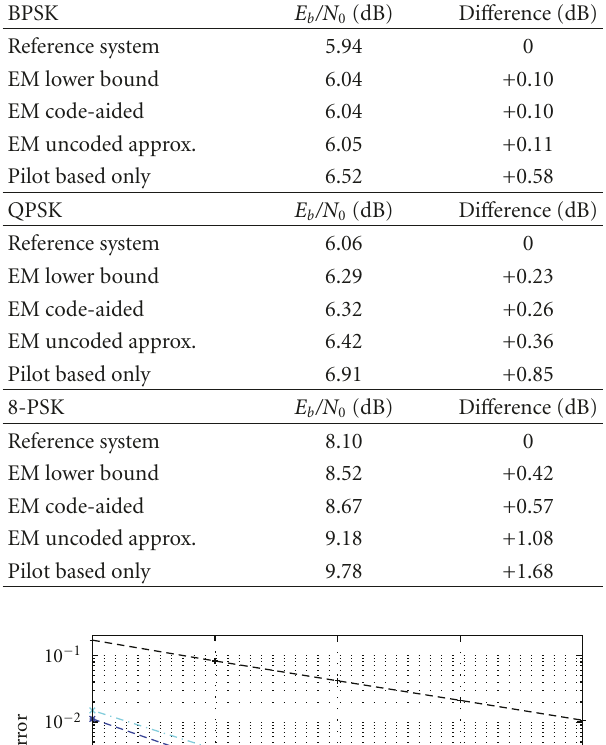
Table 2: E b /N 0 ratio needed to achieve an FER of 0.01.